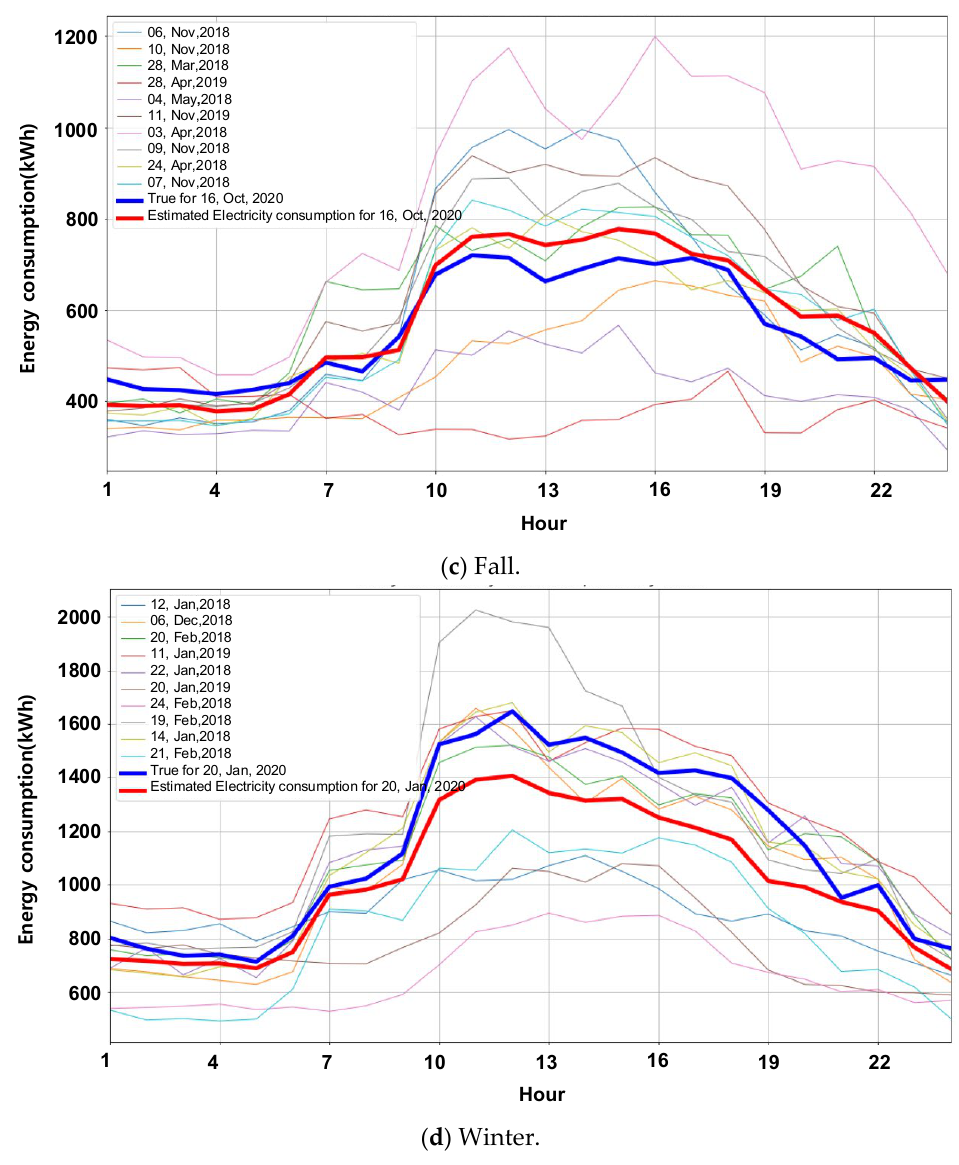
Figure 7. Energy consumption patterns by the KNN algorithm.